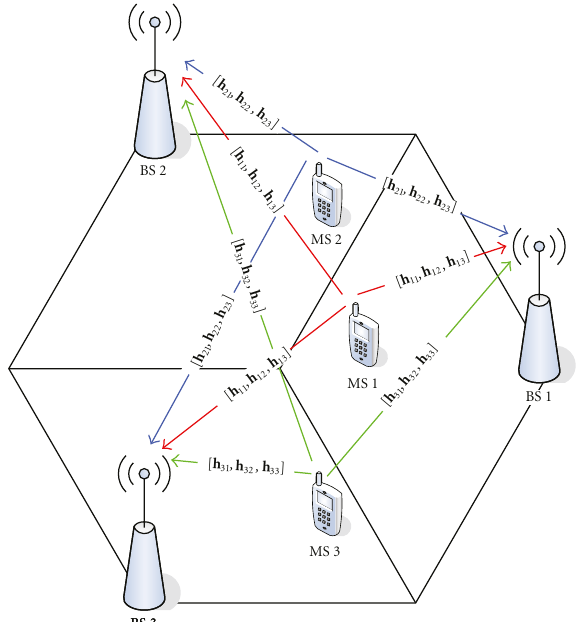
Figure 2: Phase 2 of the proposed decentralised framework: MSs feed back their CSI to all cooperating BSs which gather global CSI. User scheduling and precoding design are performed in a distributed fashion at each BS.